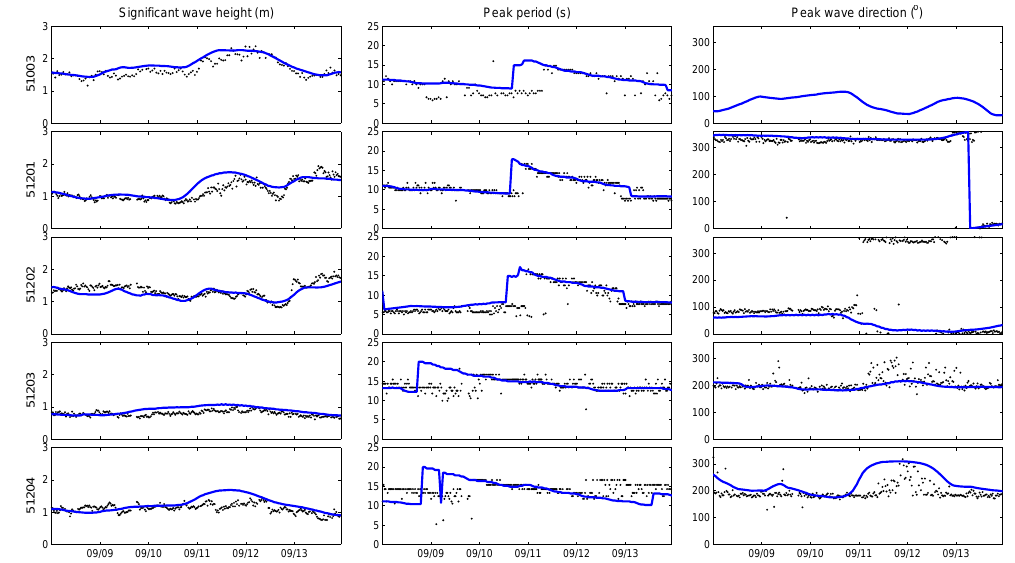
Figure 3. Comparison of the significant wave height, peak period, and direction between the NDBC buoys displayed in Fig. 1 and the wave model hindcast system results for the period of experiment 1. The black dots correspond to the buoy data and the blue line to the model results.